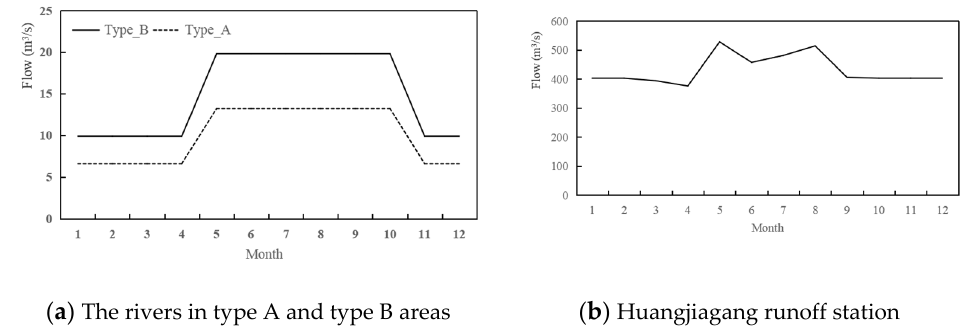
Figure 7. The in-stream ecological flows ( a ) in type A, type B areas and ( b )at the Huangjiagang runoff station. Table 5. Water demands of the socioeconomic water use in 2016 and 2030 (million m 3 ). Scenario Area